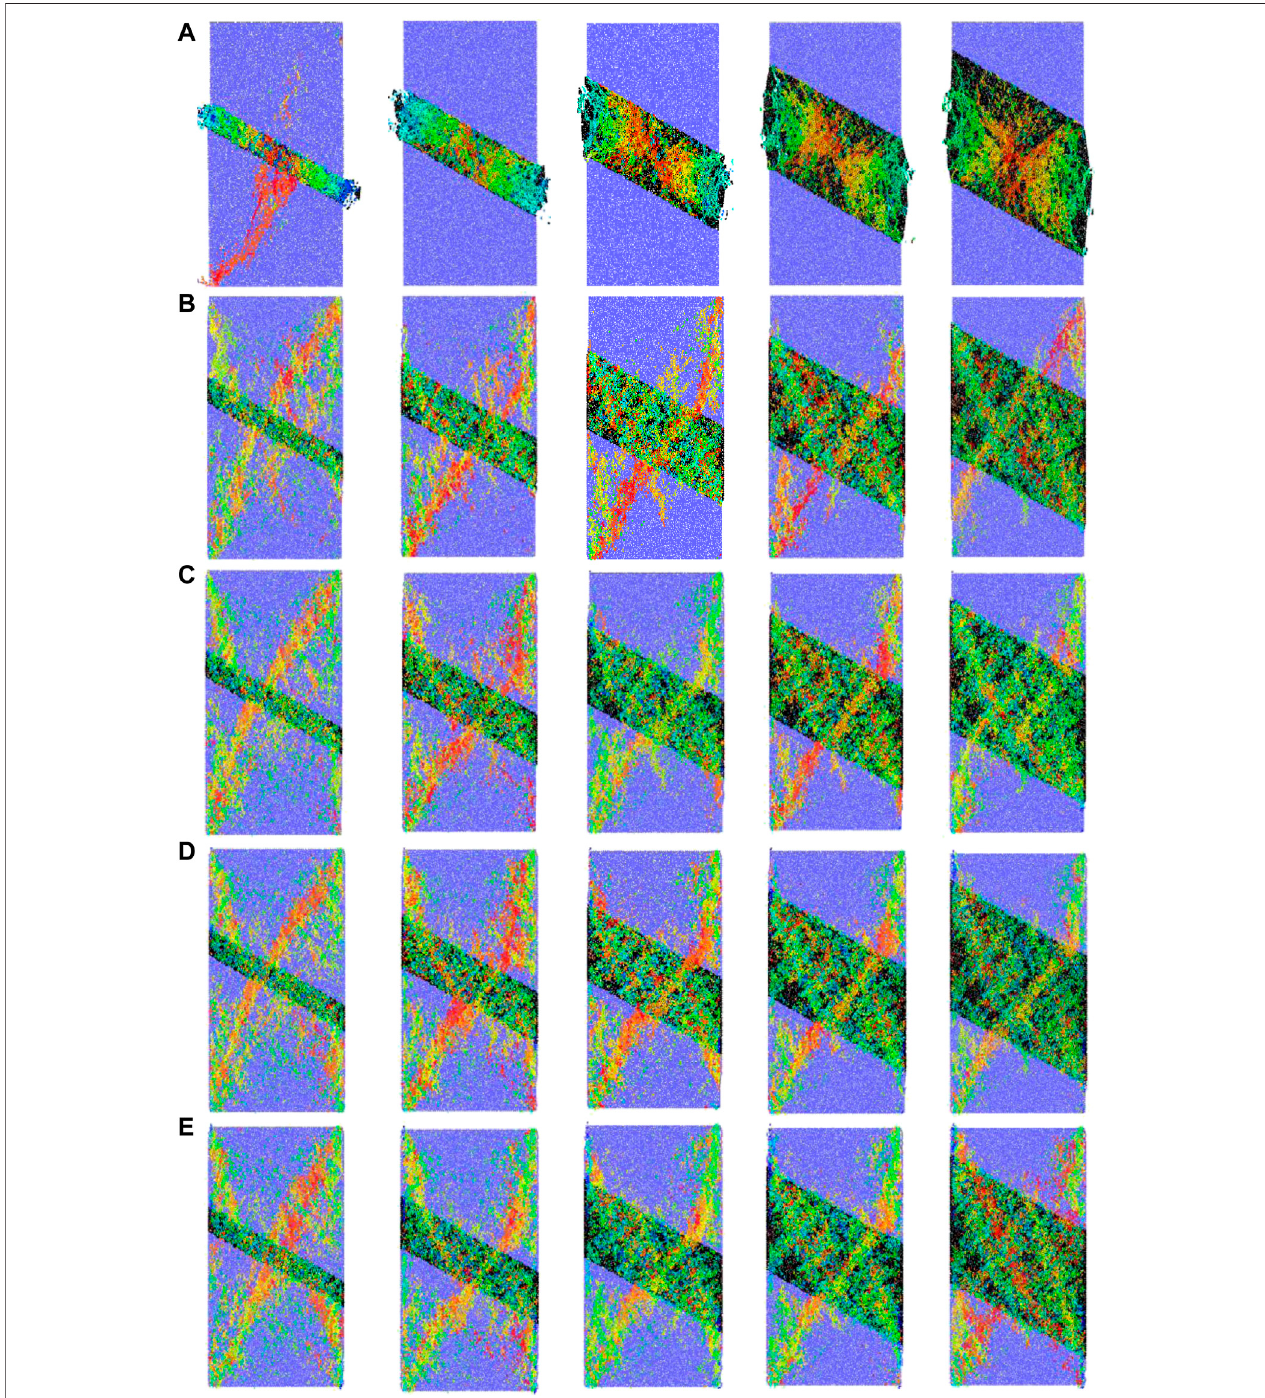
FIGURE 10 | Failure characteristics of the RCR composites at different inclined coal seam thicknesses and different con fi ning pressures. (A) σ 3 (cid:1) 0 MPa; (B) σ 3 (cid:1) 5 MPa. (C) σ 3 (cid:1) 10 MPa; (D) σ 3 (cid:1) 15 MPa. (E) σ 3 (cid:1) 20 MPa